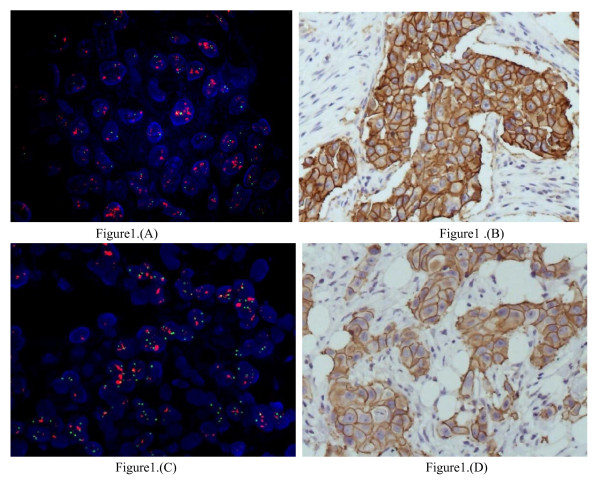
ERBB2 and EGFR gene amplification and protein expression in gastric cancer samples. (A) Representative image showing ERBB2 gene amplification in a gastric adenocarcinoma sample analyzed by FISH. The ratio of red to green signal is greater than 2, indicative of ERBB2 gene amplification (magnification, 1000 ×). (B) Representative image showing ERBB2 protein expression analyzed by IHC in a poorly-differentiated gastric adenocarcinoma (IHC score, 3+; magnification, 200 ×). (C) Representative image showing EGFR gene amplification in a gastric adenocarcinoma sample analyzed by FISH. The green signal corresponds to chromosome 7, and the red signal corresponds to EGFR. EGFR gene amplification is visible as red clustering (magnification, 1000 ×). (D) Representative image showing EGFR protein expression analyzed by IHC in a poorly-differentiated gastric adenocarcinoma (IHC score, 3+; magnification, 200 ×).